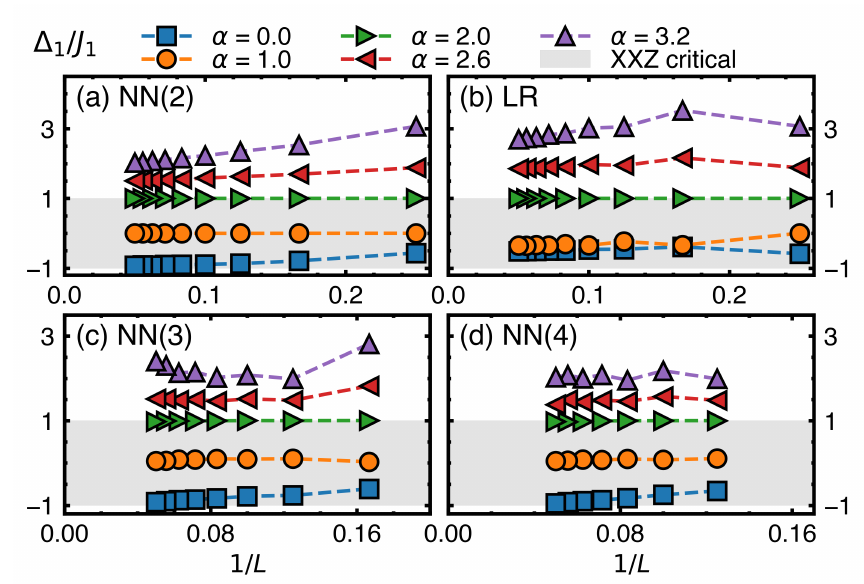
/ J over different basis 1 1